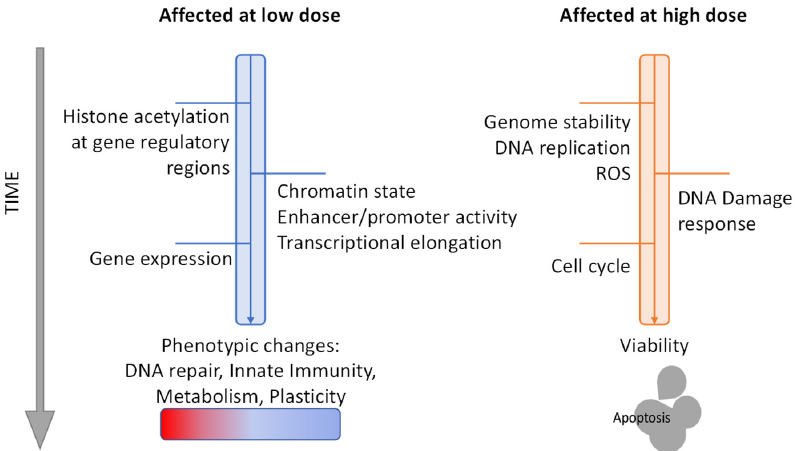
Figure 5. A perspective on how prominent effects of HDAC inhibitors take place in a time and dose-dependent manner based on the current literature.